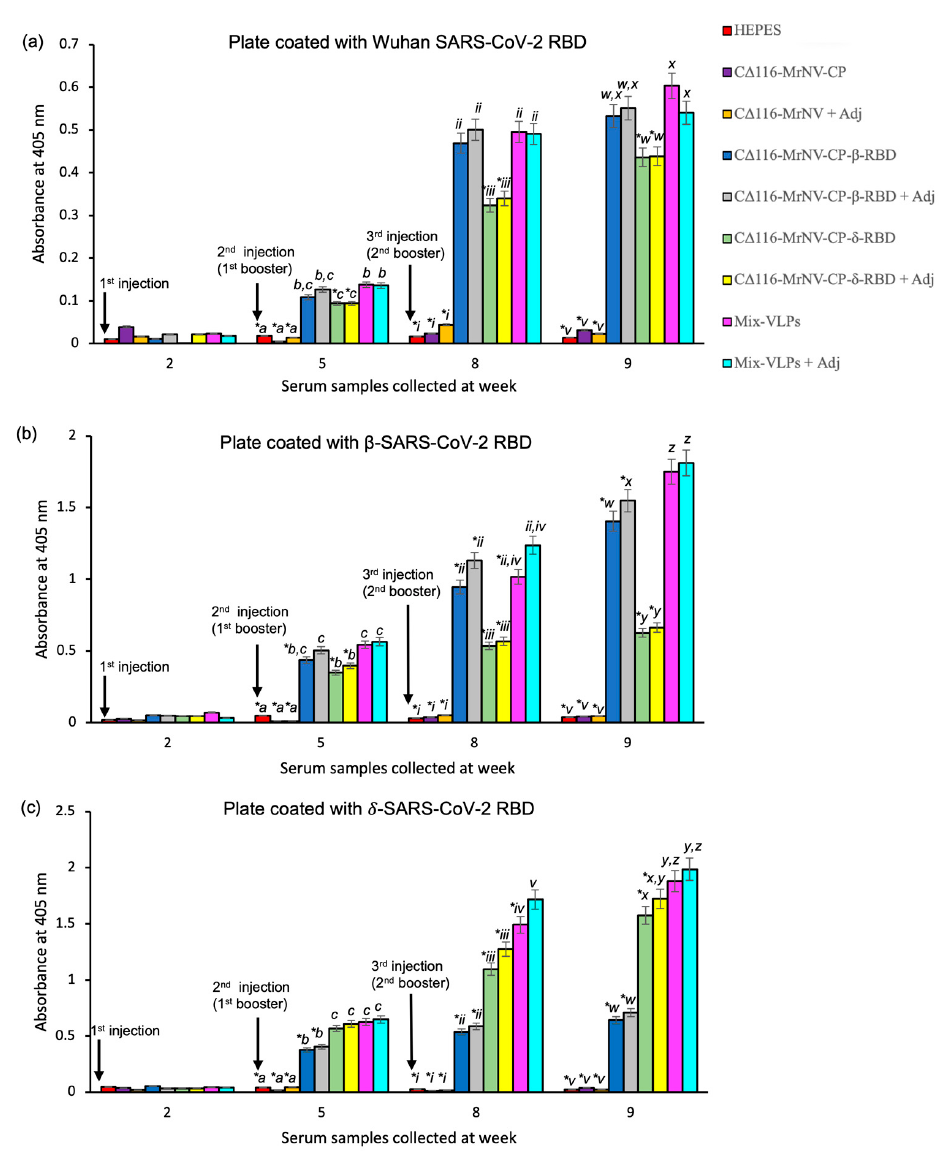
Figure 4. Immunogenicity analysis of different formulations of chimeric VLPs in BALB/c mice. Total antibodies against the ( a ) ancestral Wuhan, Wu-, ( b ) β -, and ( c ) δ -SARS-CoV-2 RBD in the sera col- lected at weeks 2 (before injection), 5 (3 weeks after 1st injection), and 8 (3 weeks after 1st booster),